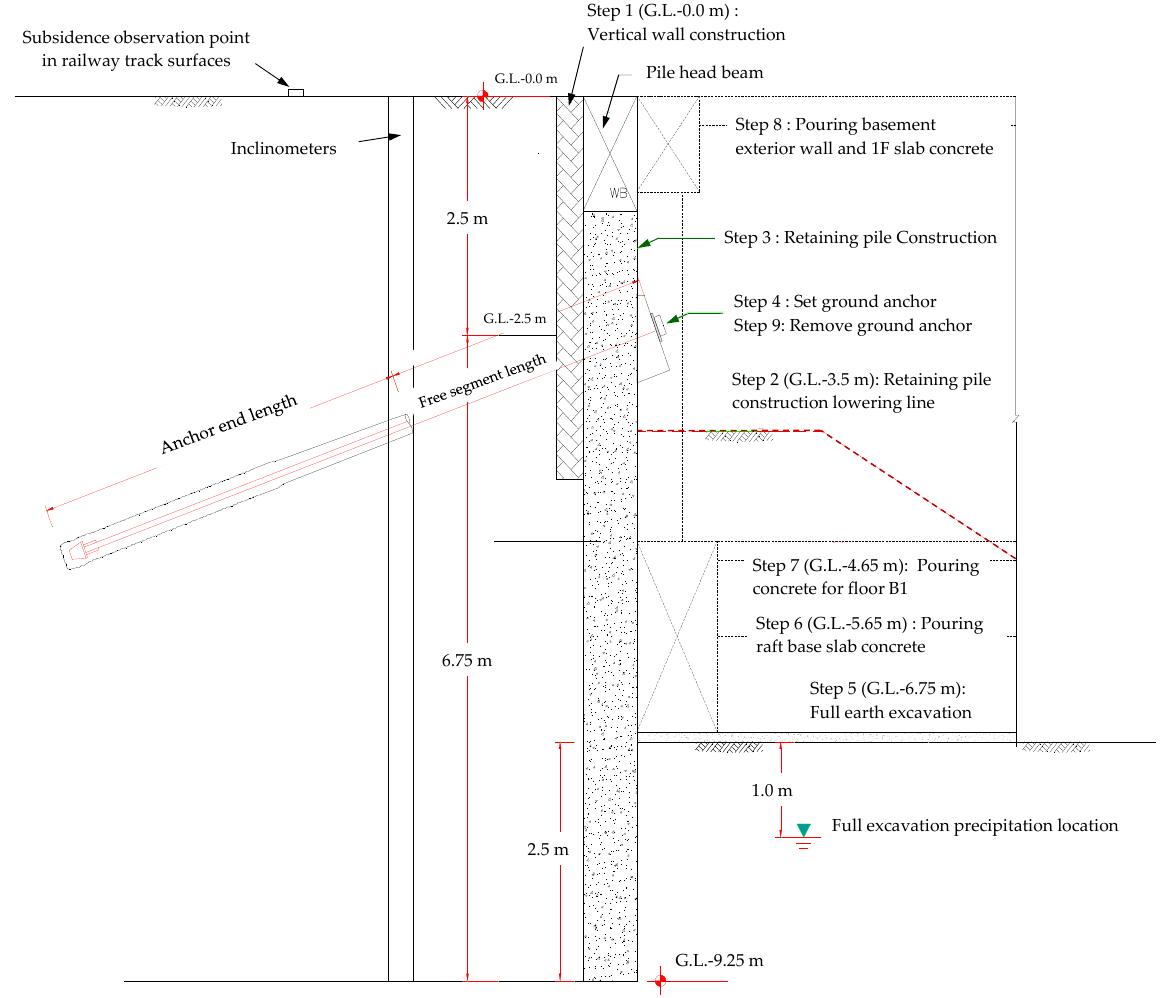
Figure 2. Diagram of the construction sequence of the excavation of the gravel layer, the vertical wall, and the retaining pile.